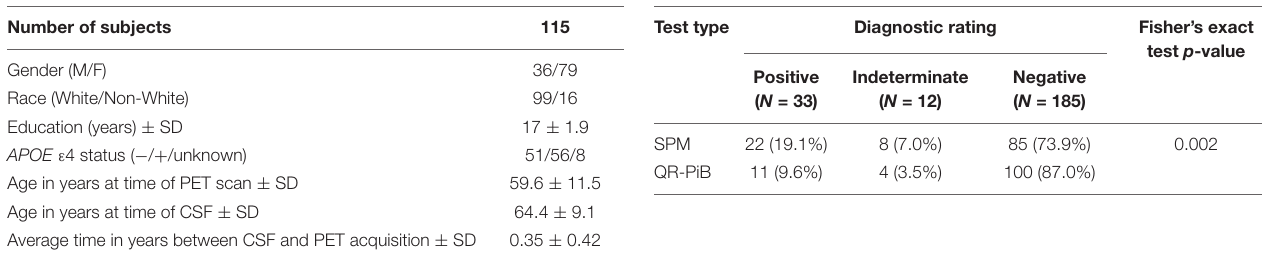
TABLE 2 | Cohort characteristics of the test group.